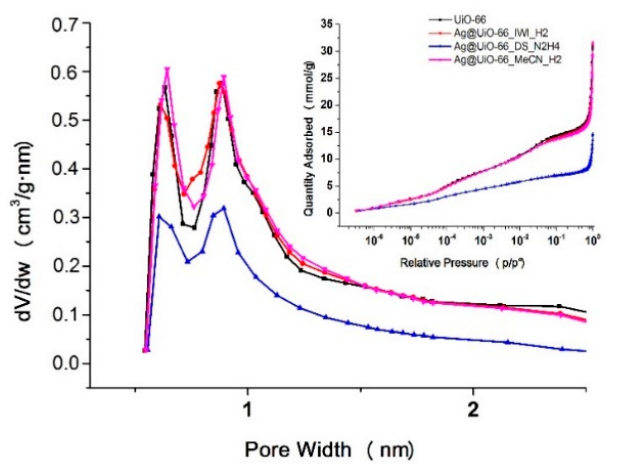
Figure 1. Pore size distributions and low-temperature N 2 adsorption-desorption isotherms (in box) of UiO-66 (black) and Ag@UiO-66 samples prepared by IWI_H 2 (red), MeCN_H 2 (magenta), and DS_N 2 H 4 (blue).